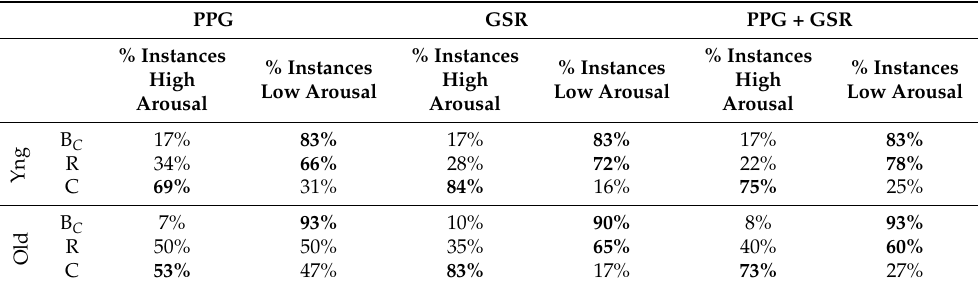
Table 5. Percentage of instances for each cognitive load task classified as high arousal and low arousal using pre-trained SVM-Linear classifiers. Each classifier has been trained considering the instances collected during the MC task as high arousal and the instances collected from AL as low arousal. The classifiers are then applied to classify the following: baseline task B C , reading task R and comprehension task C. In the first three rows, the results generated using the signals collected from young adults (Yng) are reported, while the last three rows are related to signals acquired from the older adults participants (Old). In each population group and cognitive load task, the values in bold represent the highest percentage of instances between high and low arousal for each feature set